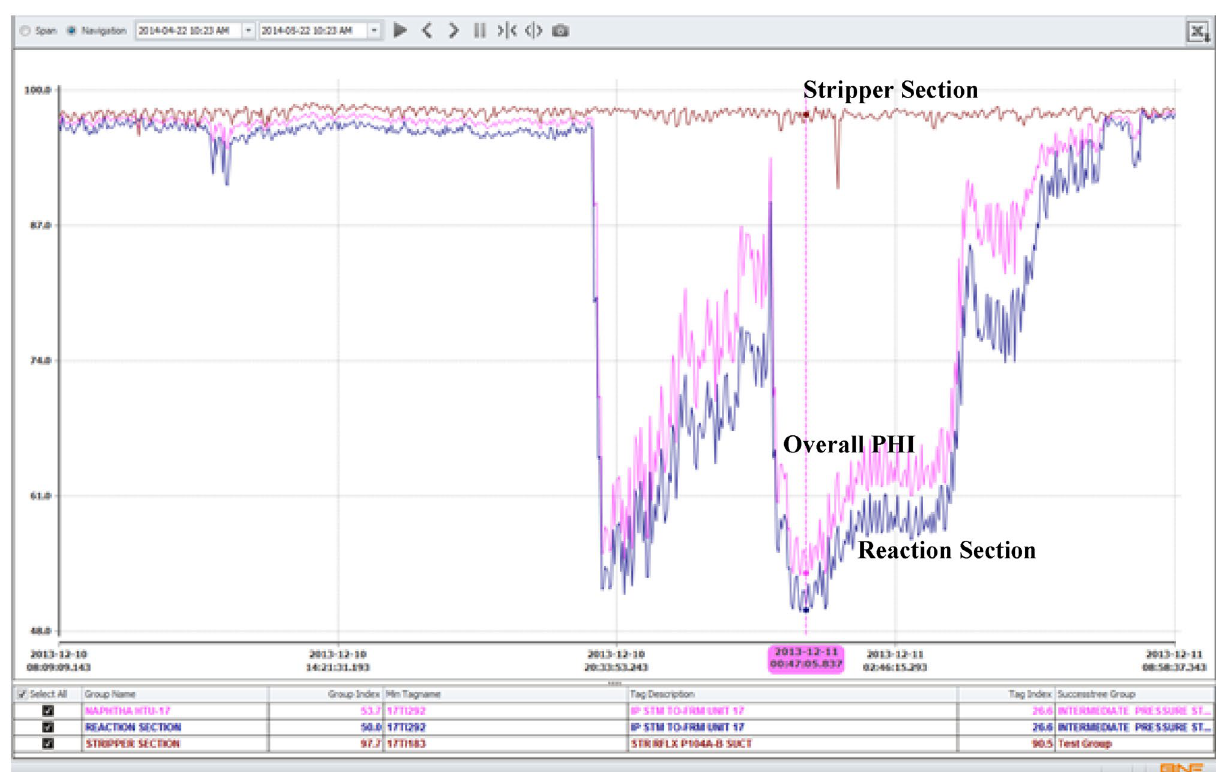
Figure 16. Case 1. Drop in steam temperature caused the drop in the health index of the reaction section and resulted in dropping the PHI to